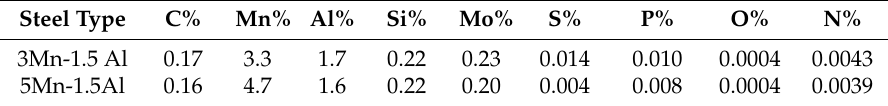
Table 1. Chemical composition of investigated steels in wt.%.